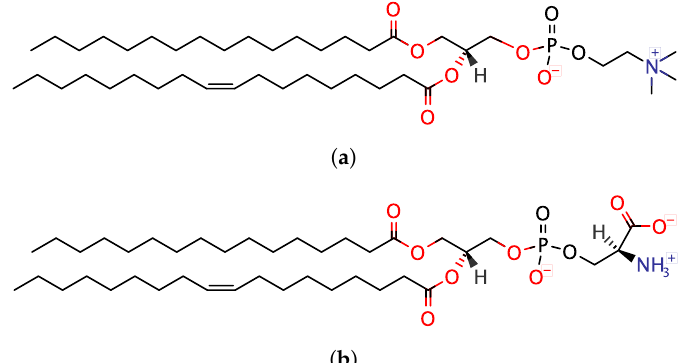
Figure 1. Lipids used for preparation of large unilamellar vesicles (LUVs): ( a ) 1-palmitoyl-2 -oleoyl-glycero-3-phosphocholine (POPC) and ( b ) 1-palmitoyl-2-oleoyl-sn-glycero-3- phospho-L-serine